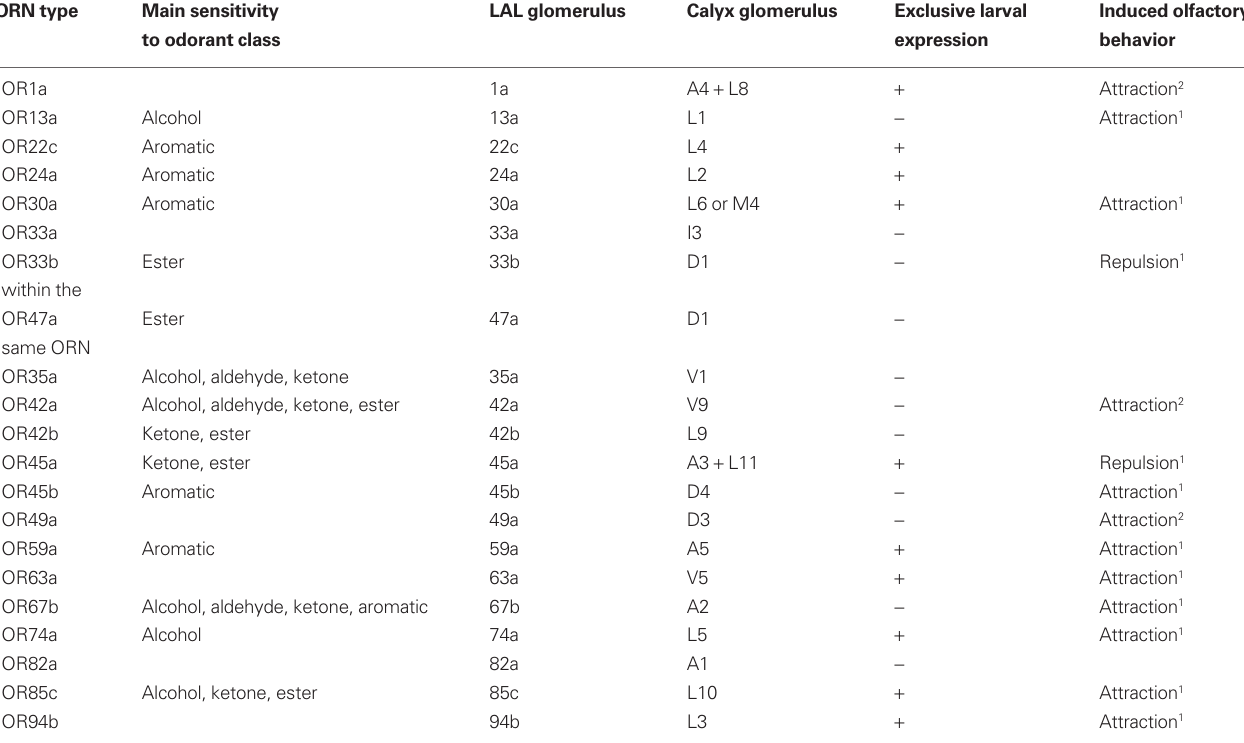
Table 1 | Overview of LAL glomerlui, their functional properties, and the resulting